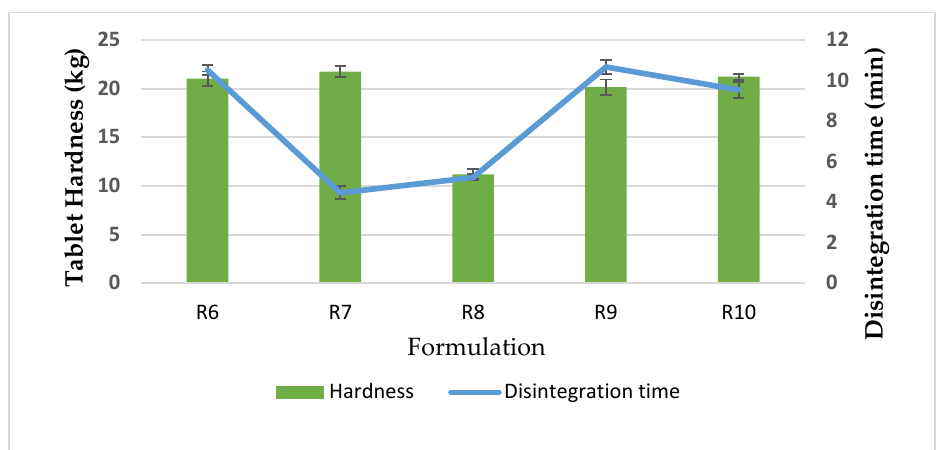
Figure 2. Tablet hardness and disintegration time of CCK R6 – R10.